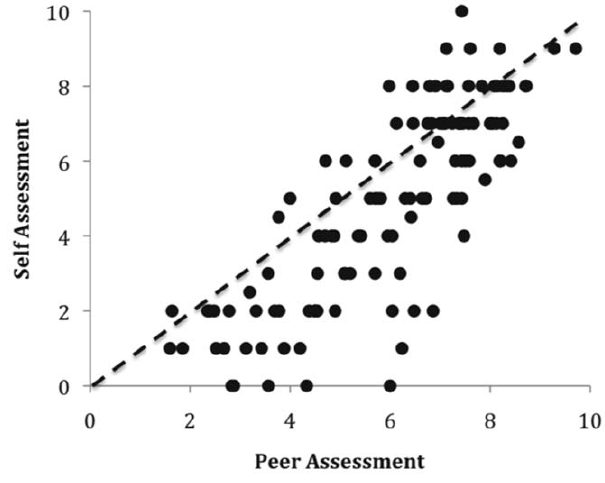
Figure 1. Self assessment versus peer assessment of expertise. Data from all workshops (overall correlation, r =0.85). Peer assessment is the average of the scores on the 11-point scale provided by each person’s peers on the day of the workshop. The strong relationship was consistent across the five groups, where the correlations ranged from 0.67 to 0.94 (Table 3). The dashed line is parity (where self assessment and peer assessment are equal).